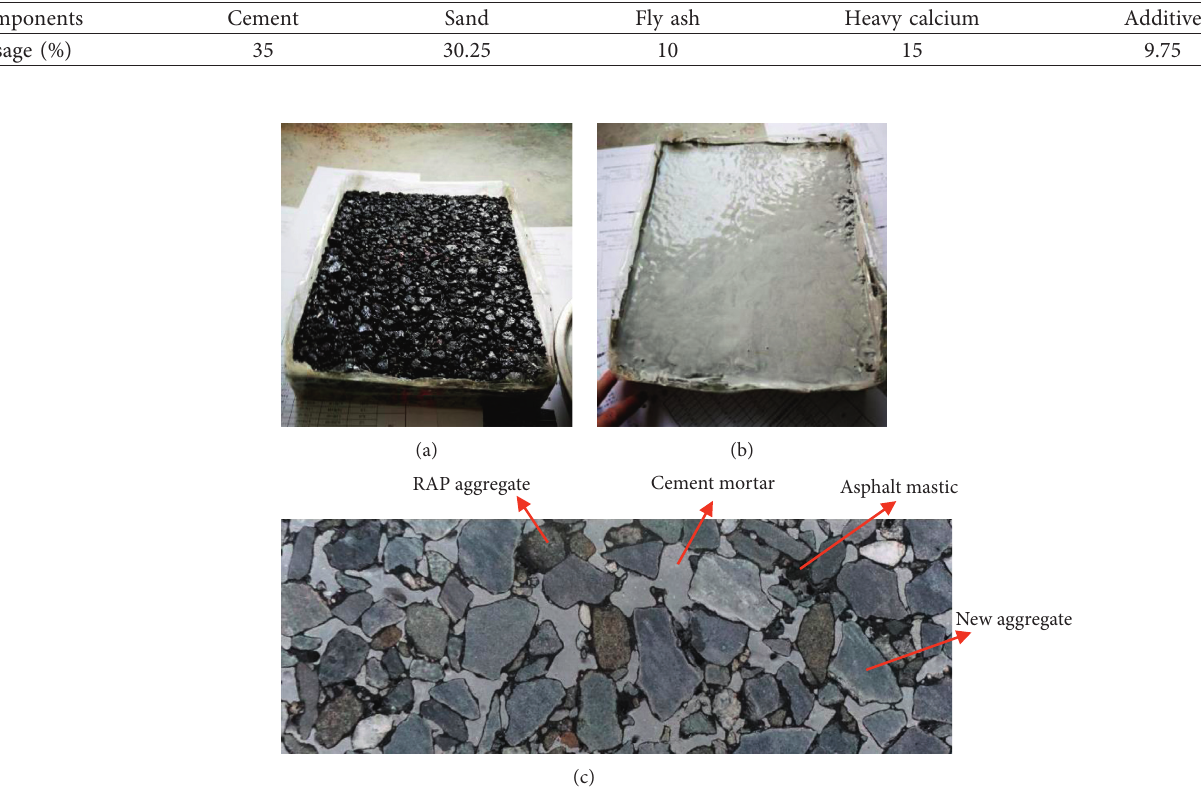
Figure 2: Brief experimental process of the semiflexible pavement materials: (a) matrix asphalt mixture slabs; (b) slab sample filled with cement mortar; (c) cross section of the semiflexible material.